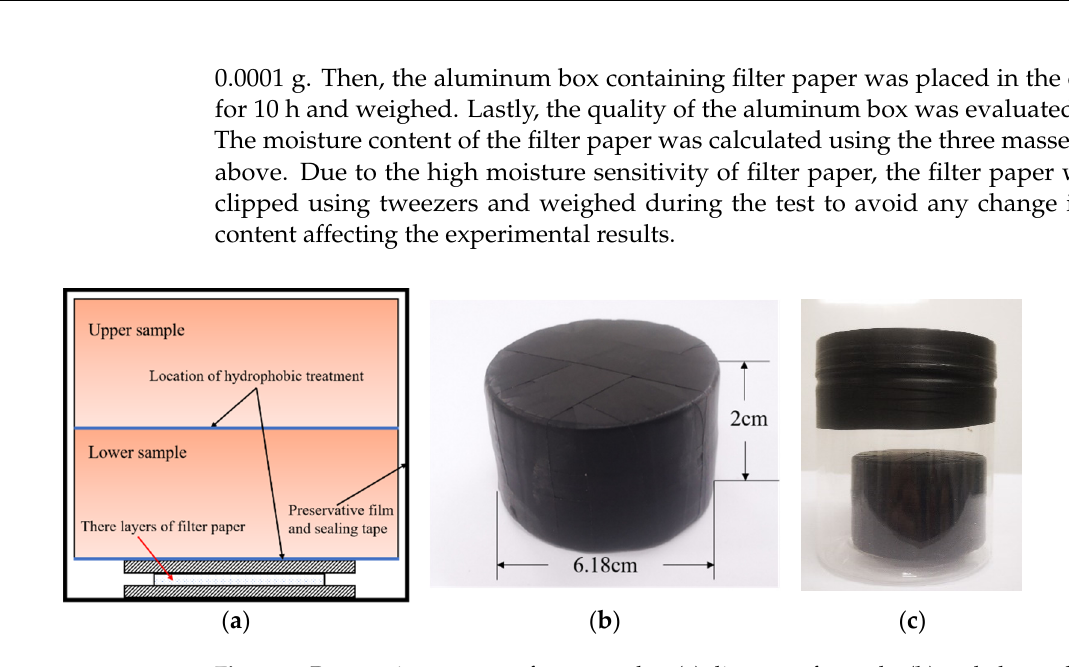
Figure 2. Preparation process of test samples: ( a ) diagram of sample; ( b ) sealed sample; ( c ) sample stored in sealed tanks.